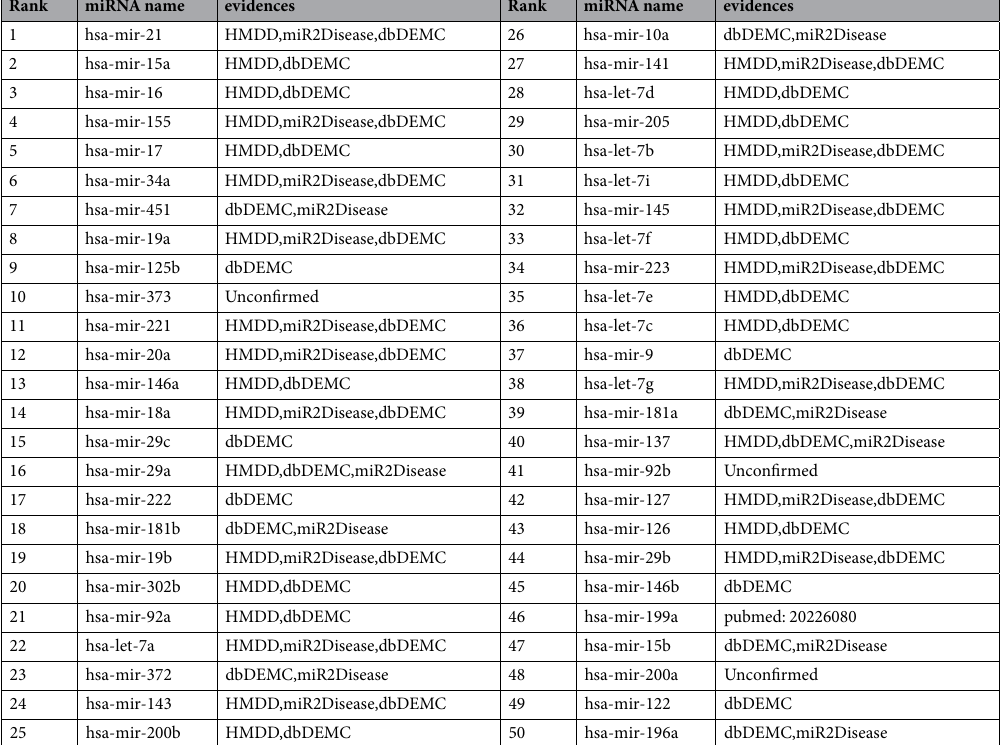
Table 4. The top 50 colon cancer-related miRNAs candidates predicted by GSTRW with removed all known colon cancer-miRNA associations and the confirmation of these associations. Forty-six of the top 50 potential conlon cancer miRNAs candidates have been confirmed based on the update HMDD, dbDEMC and